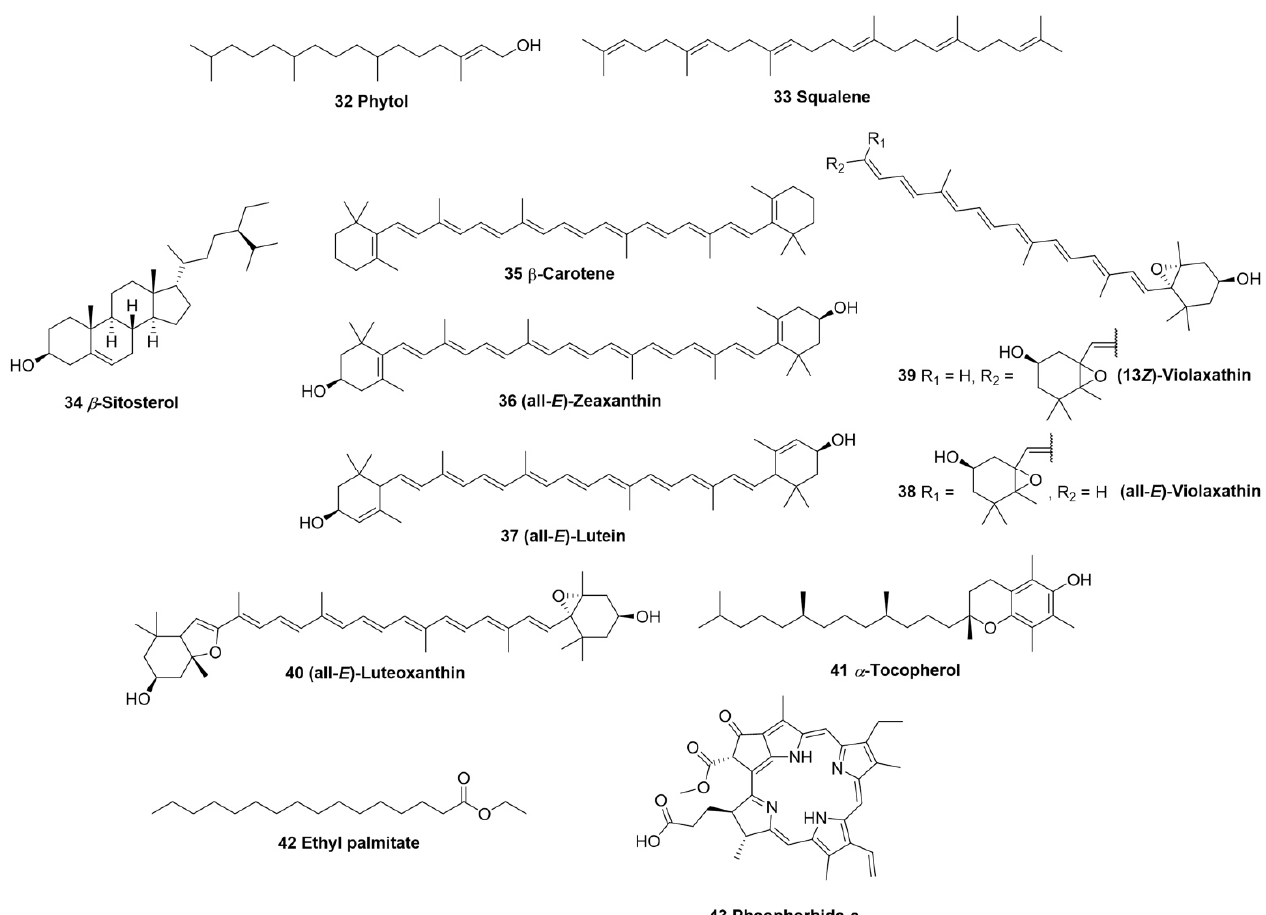
Figure 3. Terpenes ( 32 – 40 ), tocochromanol ( 41 ), fatty acid ( 42 ), and alkaloid ( 43 ) of F. chica. Table 1. Phytochemical components of F. chica extracts and their biological activities.